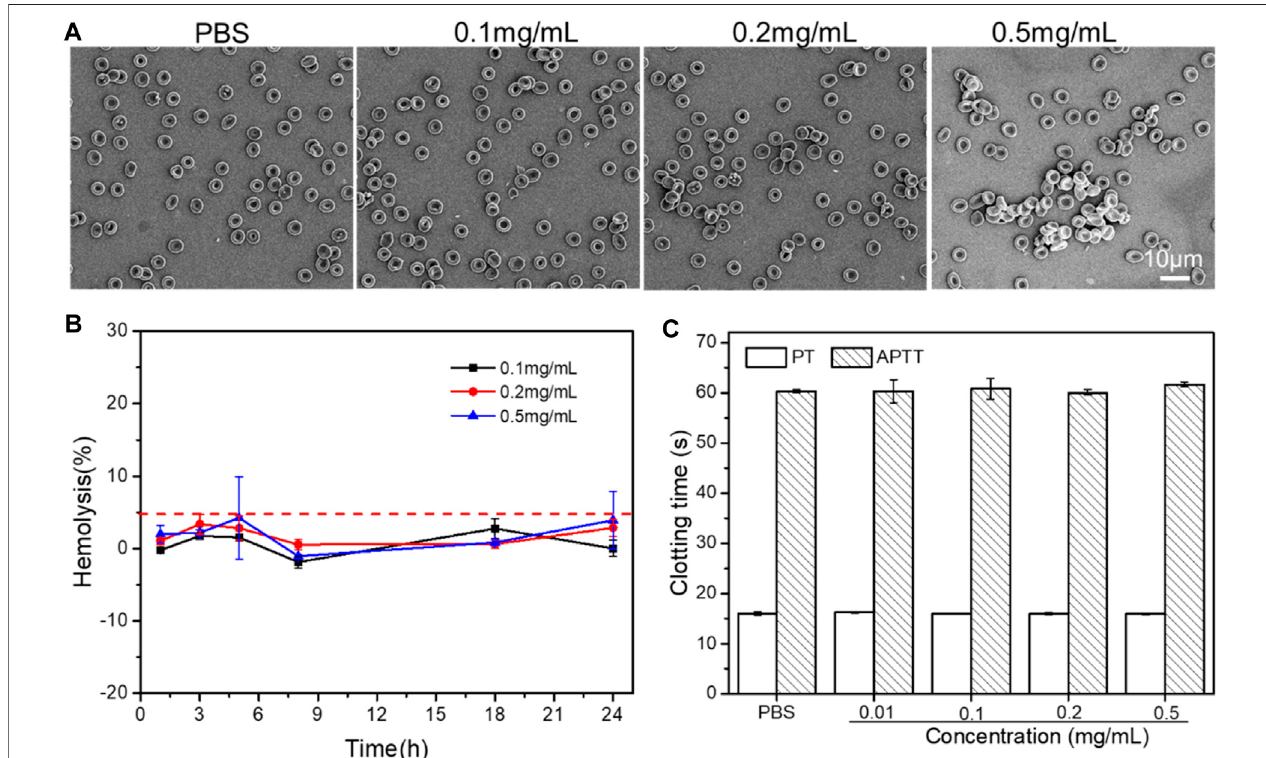
FIGURE 7 | (A) Effect of PLA-PEG-T7 with different concentrations on the aggregation and morphology of RBCs. (B) Effect of PLA-PEG-T7with different concentrations on the hemolysis. (C) Effect of PLA-PEG-T7with different concentrations on the APTT/PT.